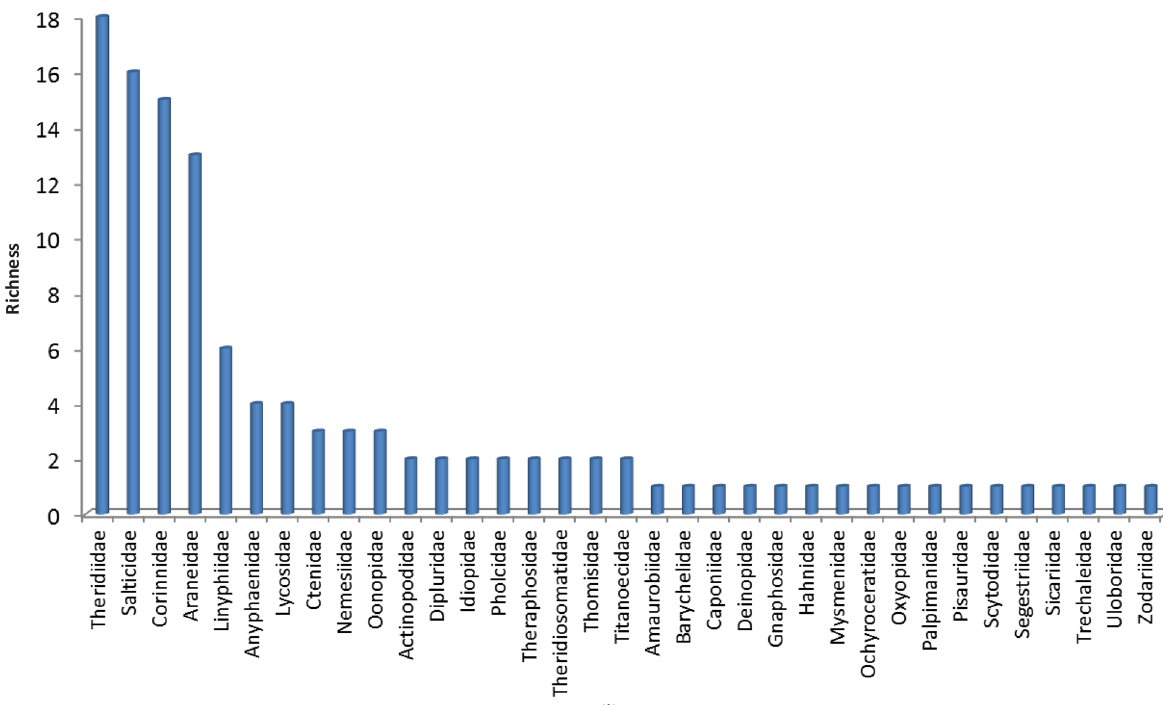
Figure 4. Total richness of spider families sampled by pitfall traps between November 2006 and August 2007 in PEJC.